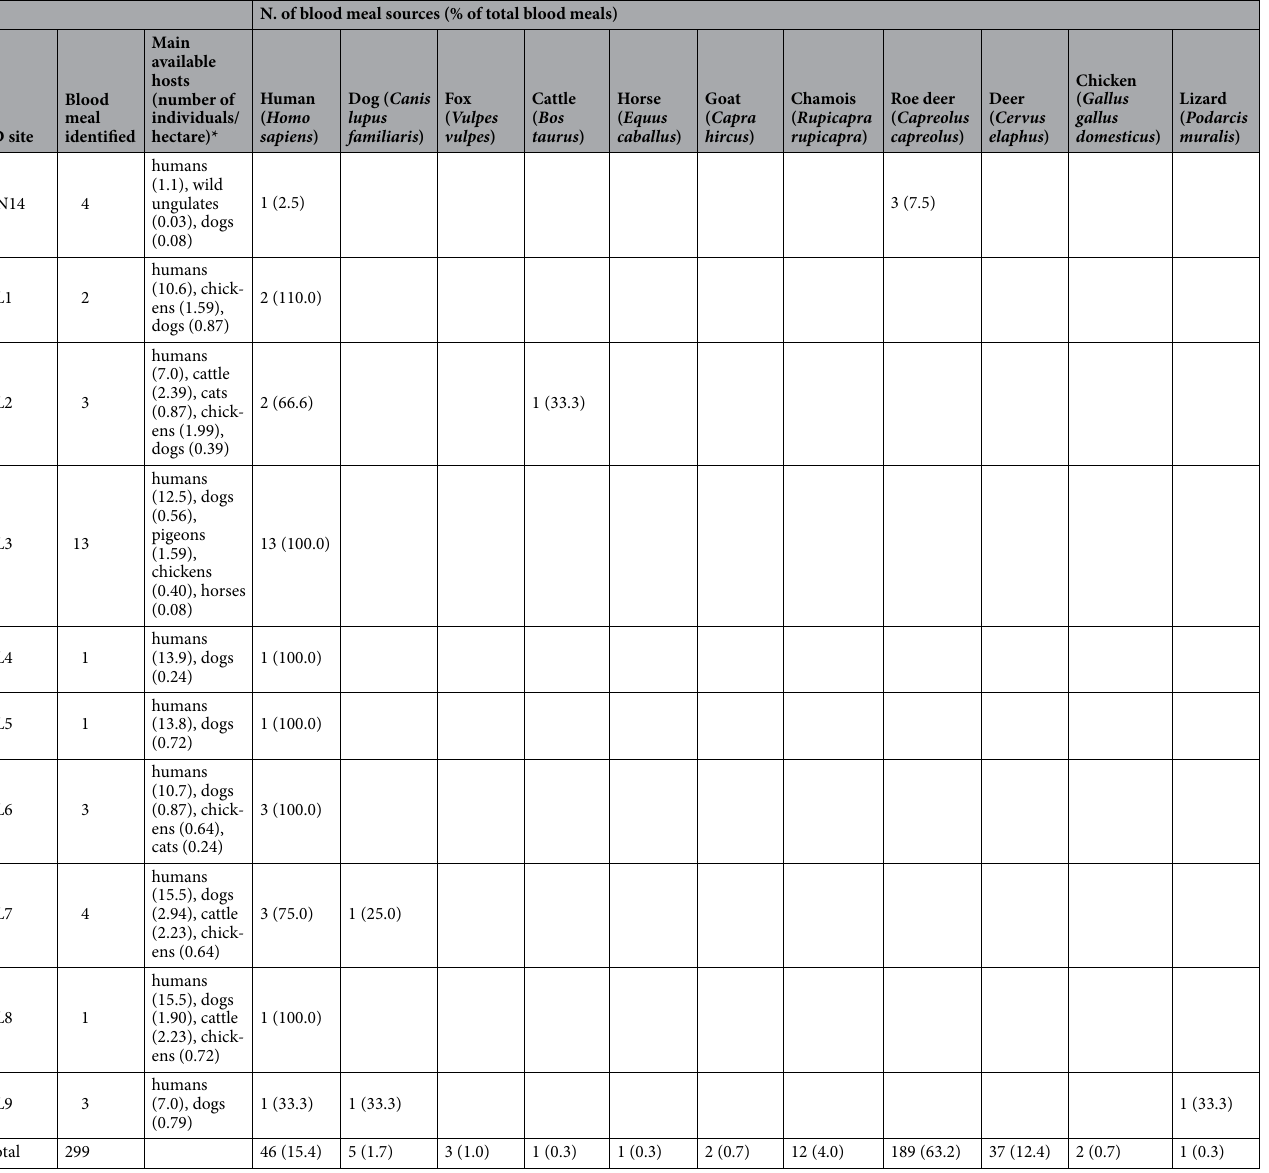
Table 2. Identified blood meals per host species in each sampling site (2013–2020). *Host density (number of individuals per hectare) at the sampling point was estimated using data from the Global Human Settlement Database 48 (human population) or from field inspections (other animals), providing a qualitative estimate of host abundance. Other wild animals, such as wild birds, small rodents, or reptiles were not counted.